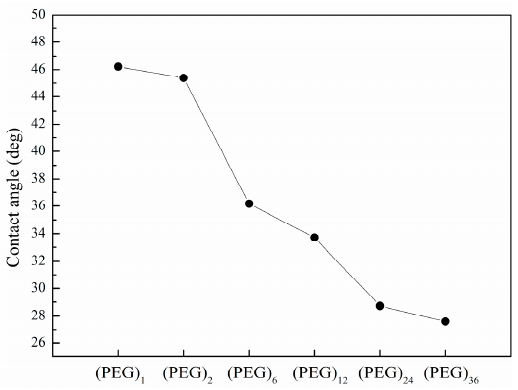
Figure 4. Contact angles of DMSO on hexyl-isocyanate functionalized surface with spacers (PEG) n of varying lengths (n = 1, 2, 6, 12, 24, 36).